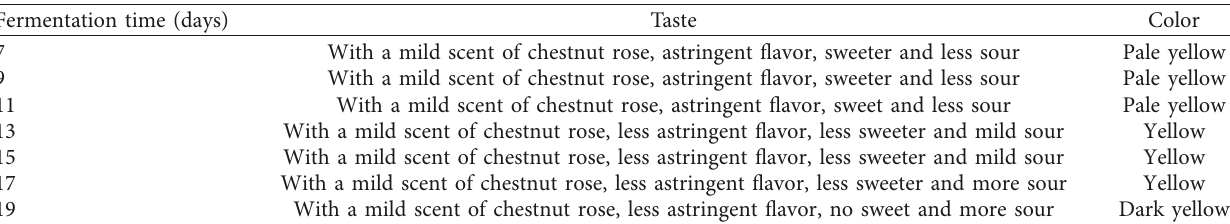
Figure 8: Variation of nitrite content with fermentation time. Table 9: Effect of different fermentation times on the taste and flavor of the jioasu.